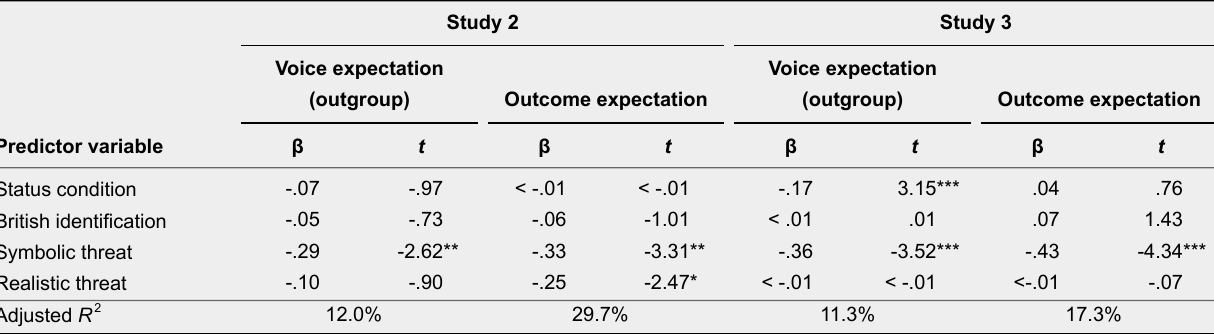
Regression Models Predicting Authority Fairness